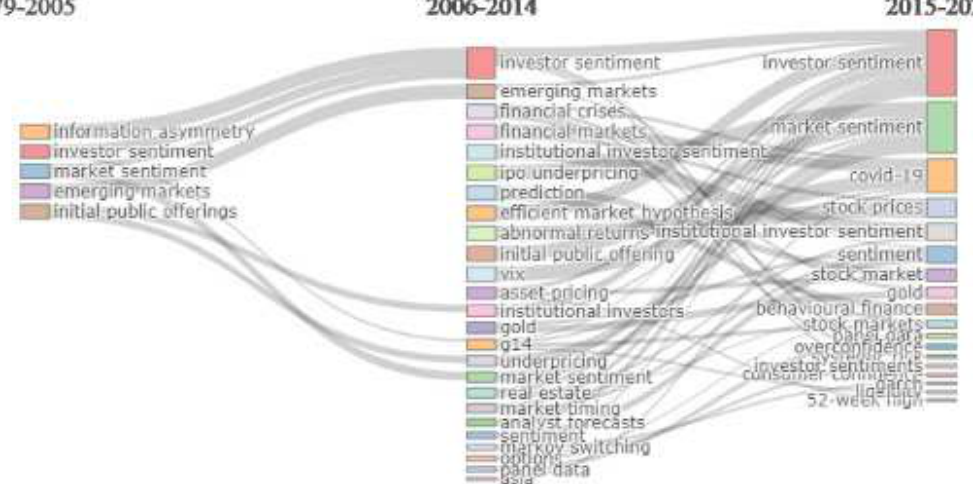
Figure 8. Alluvial diagram of thematic